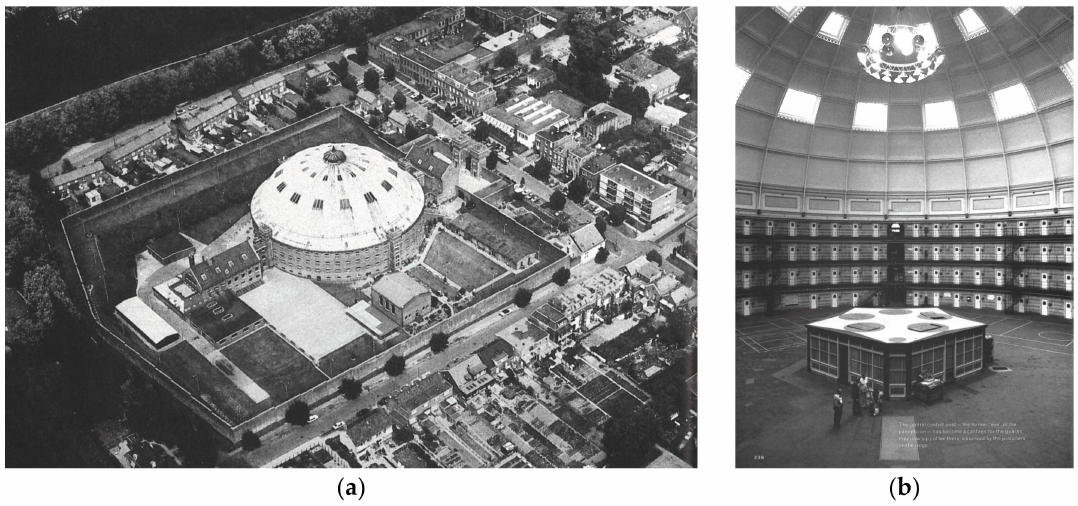
Figure 4. Photographs of the Koepelgevangenis or dome prison for the study by R. Koolhaas / OMA. ( a ) Aerial view of the prison; ( b ) the central space of the dome, the surveillance post and the